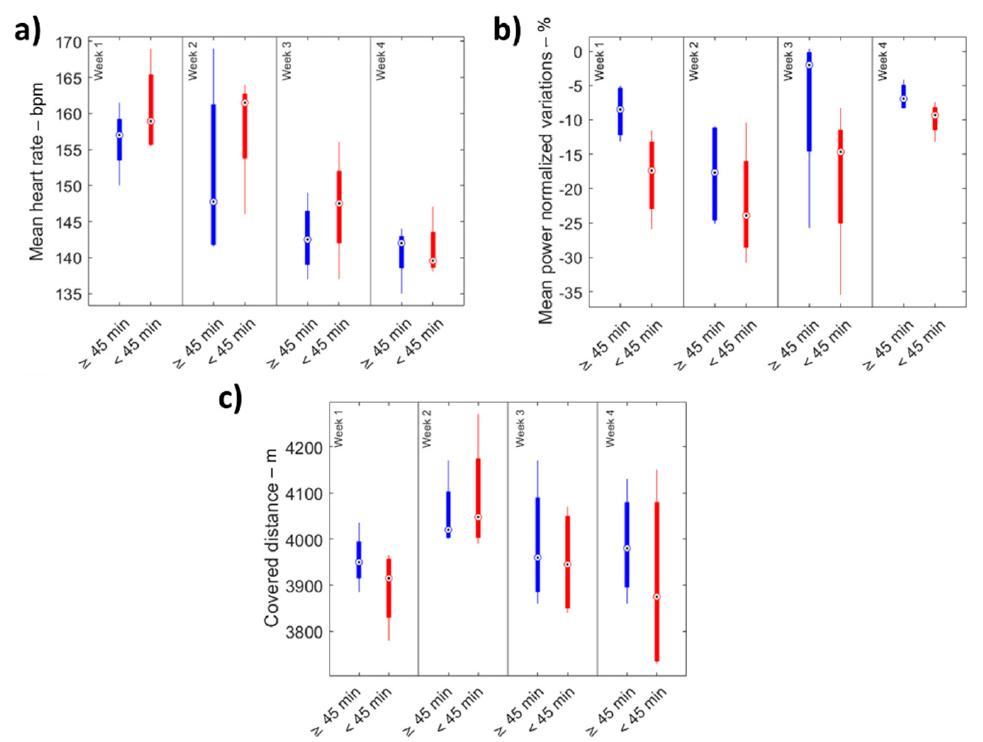
Figure 3. ( a ) Mean heart rate, ( b ) mean power normalized variations, and ( c ) total covered distance for the two different groups. Table 2. Median values, IQR and CQV for the covered distance, mean heart rate, mean and mini- mum power together eith the wilcoxon p -values and cliff’s delta effect size.